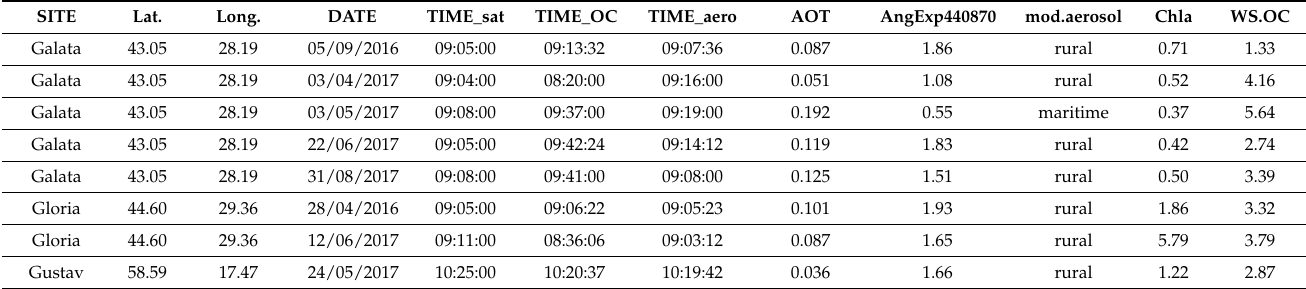
Table 2. Dataset of the MSI/S2A images acquired over the AERONET-OC stations with quasi-synchronous AERONET- OC